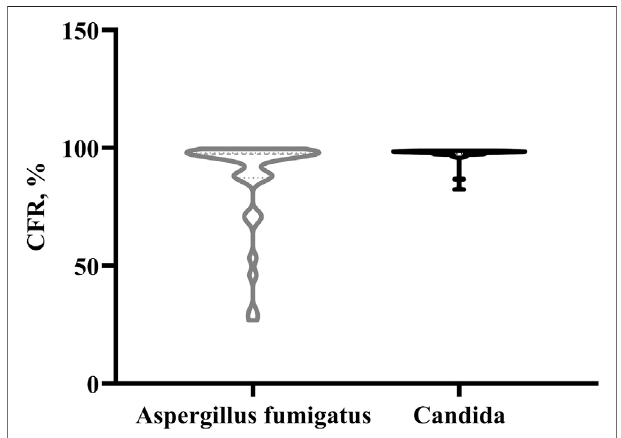
FIGURE 1 | The violin plot of CFR distribution for Aspergillus fumigatus and